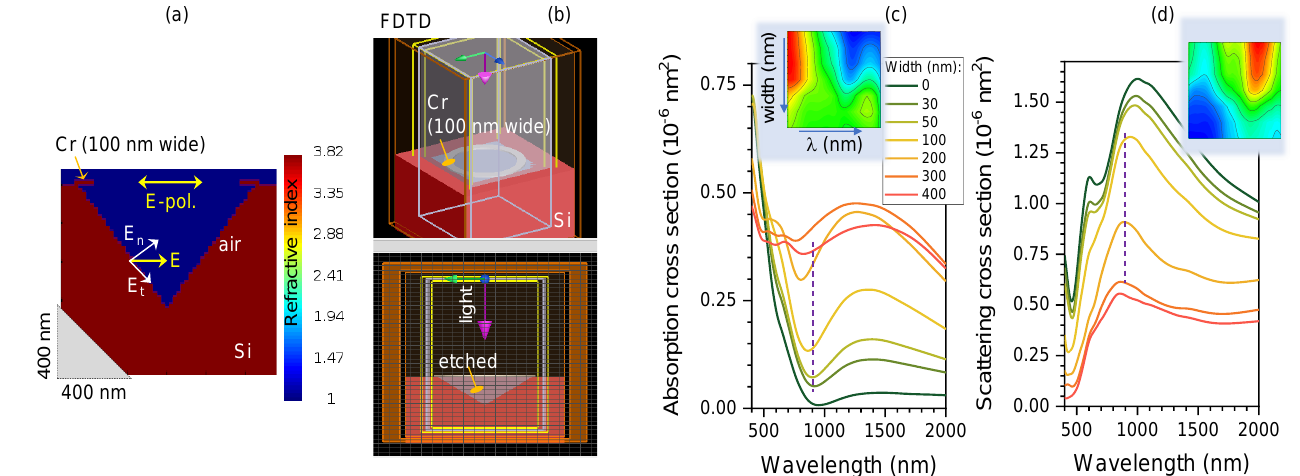
Figure 7. FDTD simulations (Lumerical ANSYS). ( a ) Refractive index cross section of a 30-nm-thick and 100-nm-wide Cr ring with outer diameter 950 nm. The linear polarisation of E-field is projected at the Si–air interface as normal and tangentical components ( E n , E t ). ( b ) Calculation volume in slanted and side views. ( c , d ) Absorption and scattering cross sections σ ab , sc , respectively, for the different width Cr rings with outer diameter 950 nm and 30 nm thickness. Inset pictograms show map diagrams with blue-red color scale corresponding low-high σ ab ( c ) and σ sc ( d ). Material properties are taken from Lumerical database, which refers to Palik’s data